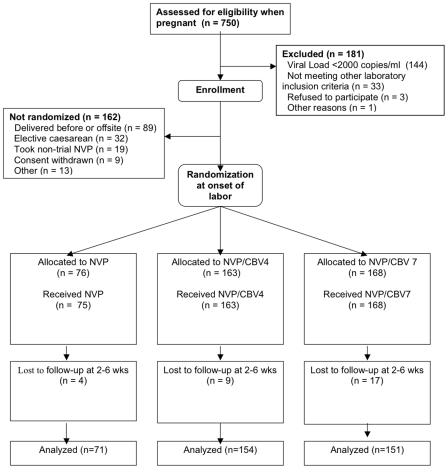
CONSORT diagram of the trial.Screening was while women were pregnant and randomisation was during labour (CBV, 3TC with AZT).